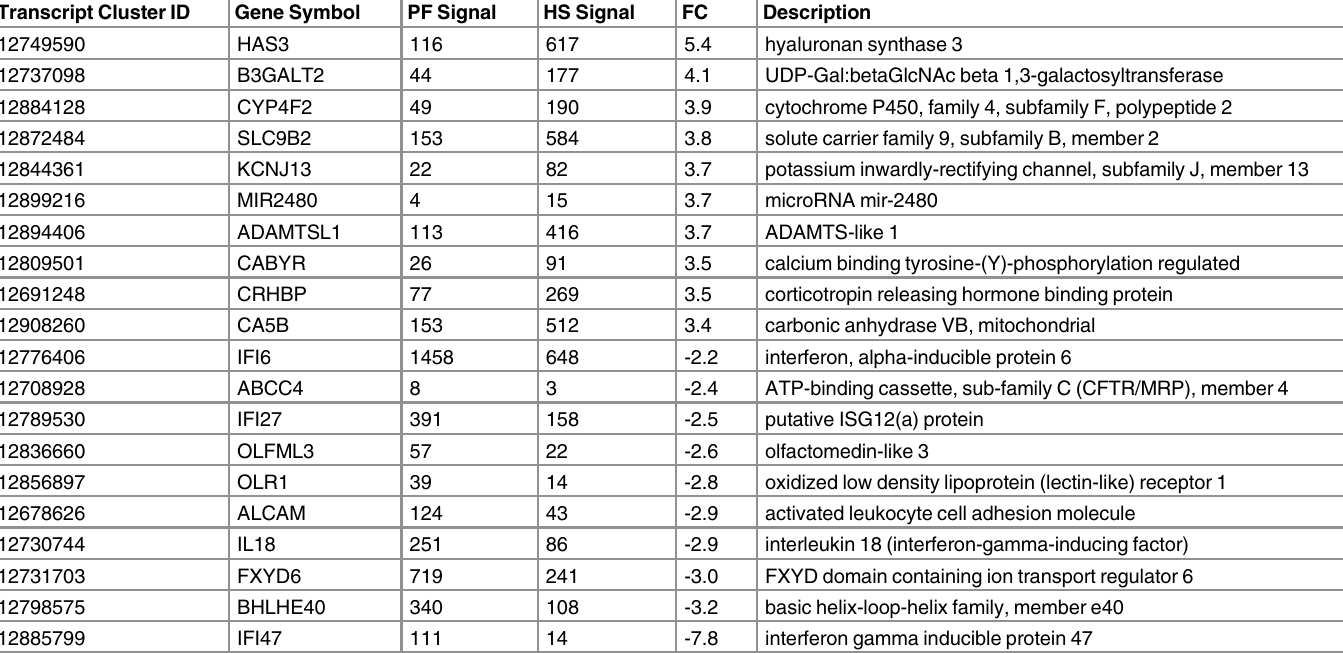
Table 4. Top 20 regulated genes according to microarray analysis. Mean hybridization signals and fold change (FC) differences are shown. Transcript Cluster